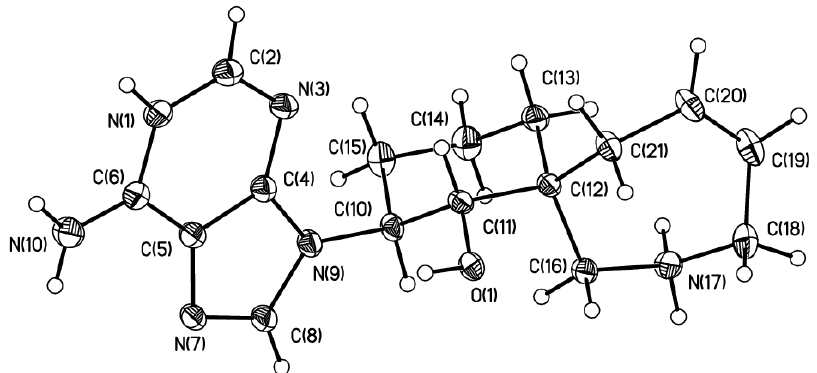
Figure 1. The molecular structure of dication 3 . Displacement ellipsoids are shown at a 50% proba- bility level.